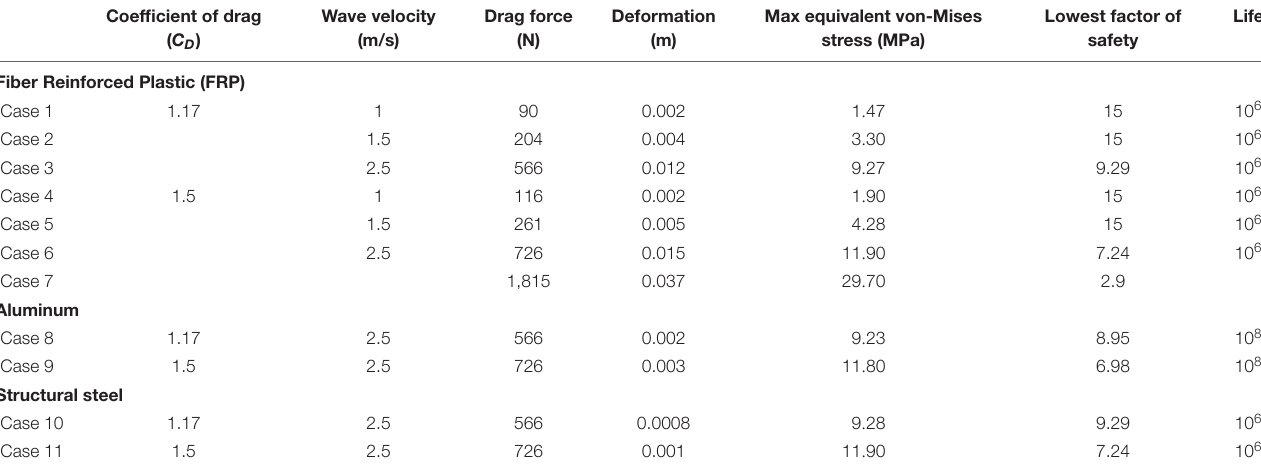
Lowest factor of safety